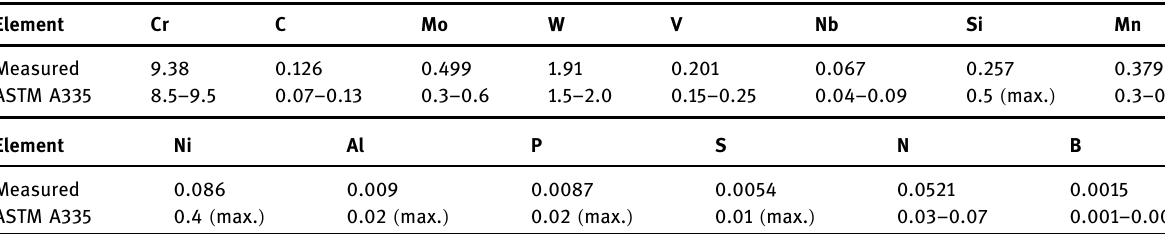
Table 1: Chemical composition of P92 steel Element Cr C Mo W Nb Mn Measured